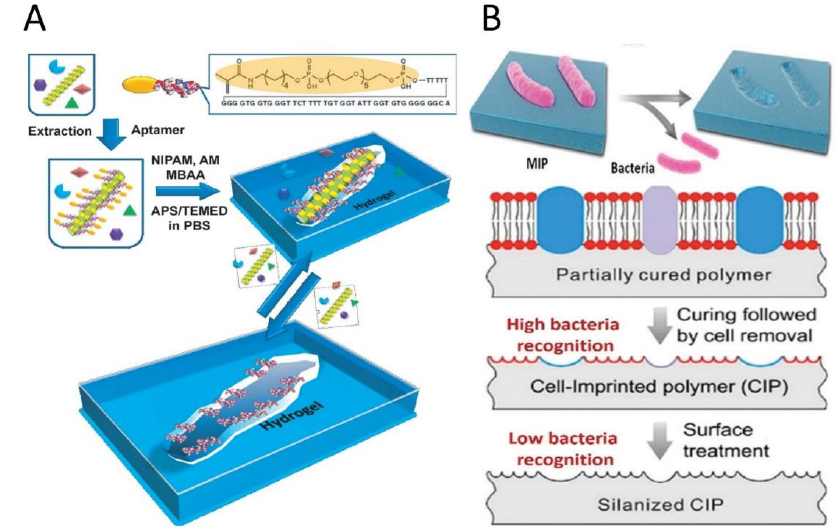
Figure 4. ( A ) Preparation process for virus sensitive super-aptamer hydrogels MIPs. Reproduced from [25]—Published by John Wiley and Sons. ( B ) Schematic diagram of cell-imprinted polymers